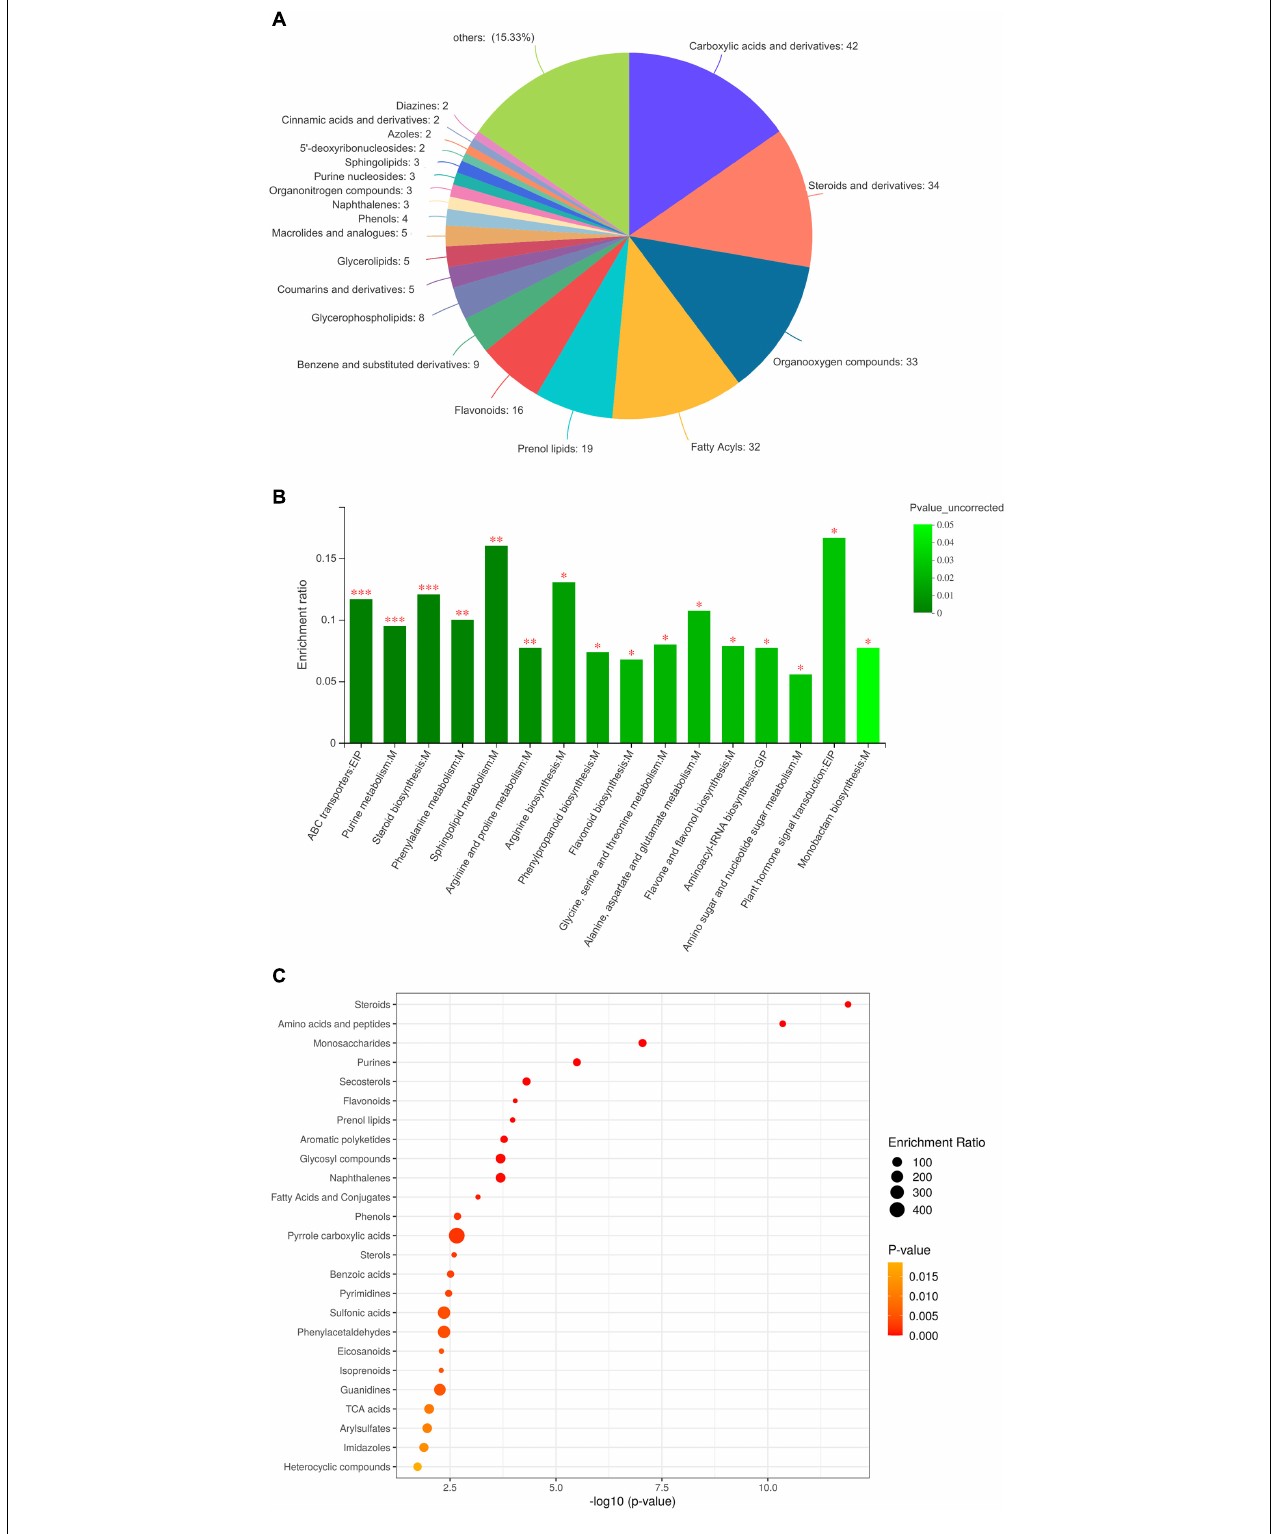
FIGURE 2 | Functional annotation and classification of differential metabolites identified in the comparison between JY and CK group. (A) Classification of differentially expressed metabolites (DEMs), (B) KEGG enrichment analysis of DEMs, and (C) Bubble plot of KEGG pathway of DEMs.